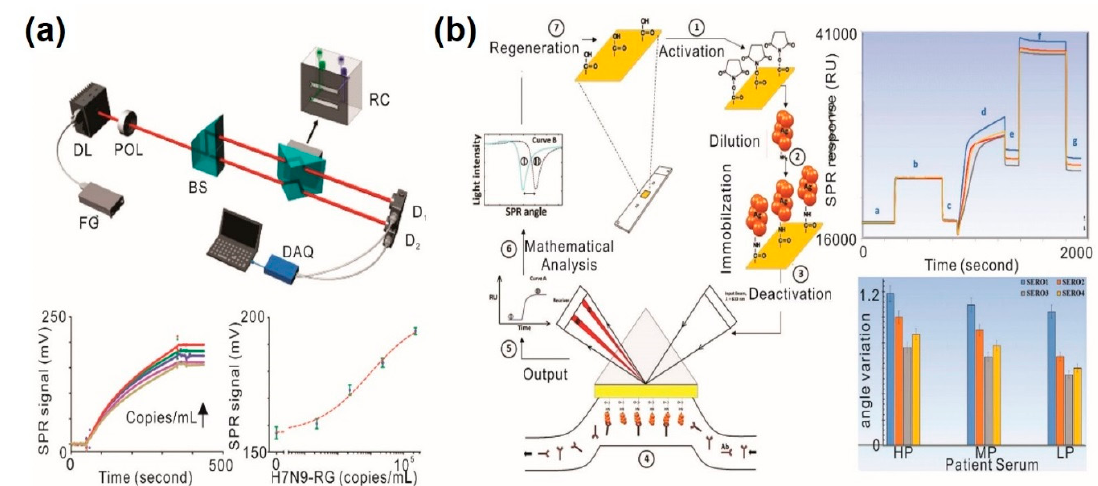
Figure 3. SPR-based immunosensors for viral agents detection. ( a ) Detection of Avian Influenza A H7N9 Virus by SPR-based immunosensor; ( b ) selective recognition of four di ff erent serotypes of dengue virus by SPR-based immunosensor from clinical samples. ( a ) Figure reproduced with permission from [47], © 2018 American Chemical Society; ( b ) Figure reproduced with permission from [48], © 2014 Springer